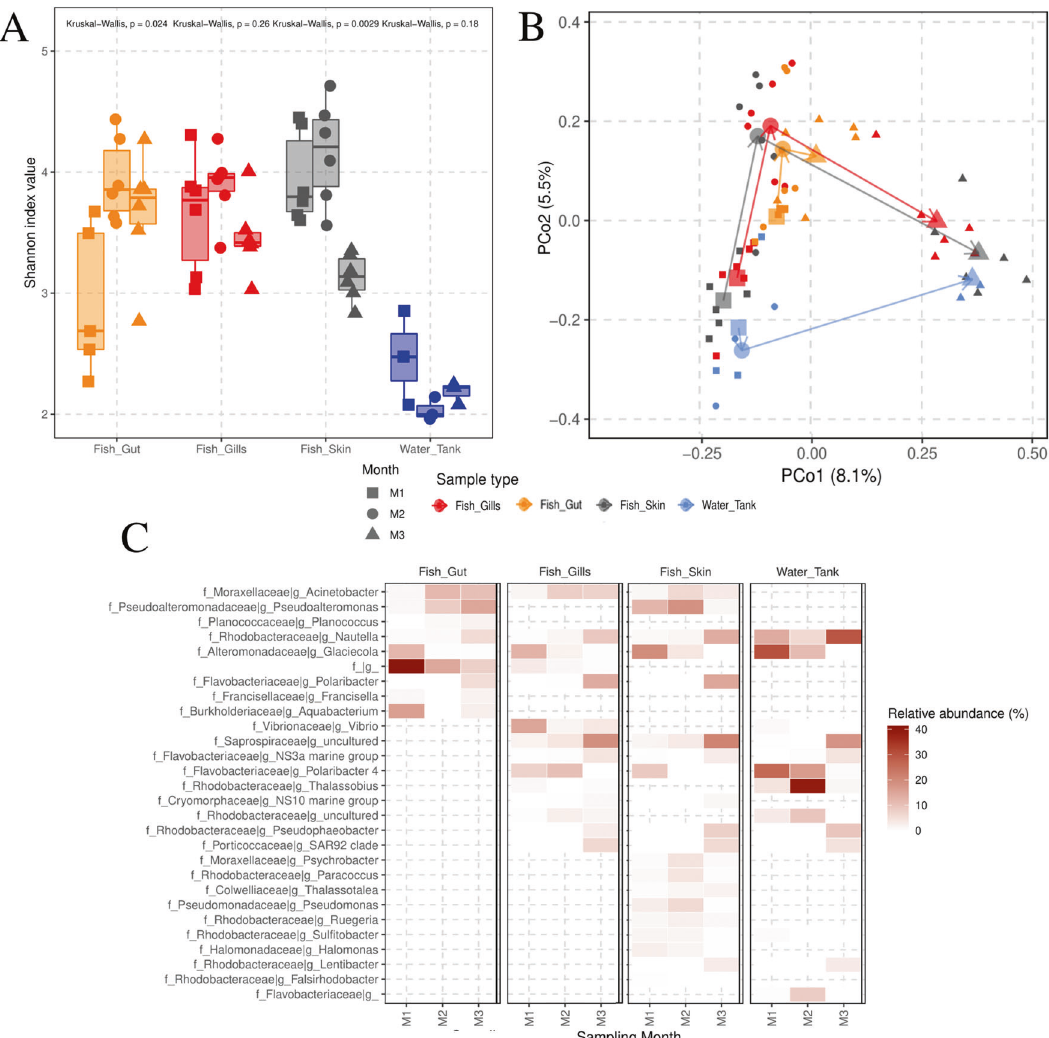
Fig. 1 General characterization of greater amberjack ’ s microbiota. A Alfa-diversity distribution analysis for the different types of samples assessed: skin, gills, gut and water. For each type of sample, at each of the selected timepoints, the individual Shannon value is represented by points, and the niche ’ s richness distribution, as a boxplot, with the median of the distribution indicated as a horizontal bar. Kruskal – Wallis test is presented for each sample type, indicating a signi fi cative change over time ( p < 0.05). B Beta diversity PCoA, computed upon the Bray – Curtis distance matrix, displaying fi sh and water samples from the control temperature tanks (24 °C). Samples from different timepoints are shown in different shapes: squares for Month 1 (M1), circles for Month 2 (M2) and triangles for Month 3 (M3). Each sample type ( fi sh skin, gills, gut and water) has been colored differently. For each combination of samples belonging to the same type and month, we computed and plotted the centroid of the corresponding cluster. Afterwards, centroids belonging to the same sample type have been joined sequentially depending on the sampled month (M1 - >M2 - >M3), to show the trajectory of the bacterial community over time. Explained variance for each of the coordinates is indicated between parentheses next to the corresponding axis. C Heatmap displaying the relative abundance (%) of those bacterial genera found to be differentially abundant, in greater amberjack and water bacterial communities, in relation to the sampling timepoint. Signi fi cance was assessed with an ANOVA test upon the CLR-transformed genera counts, comparing between the three months